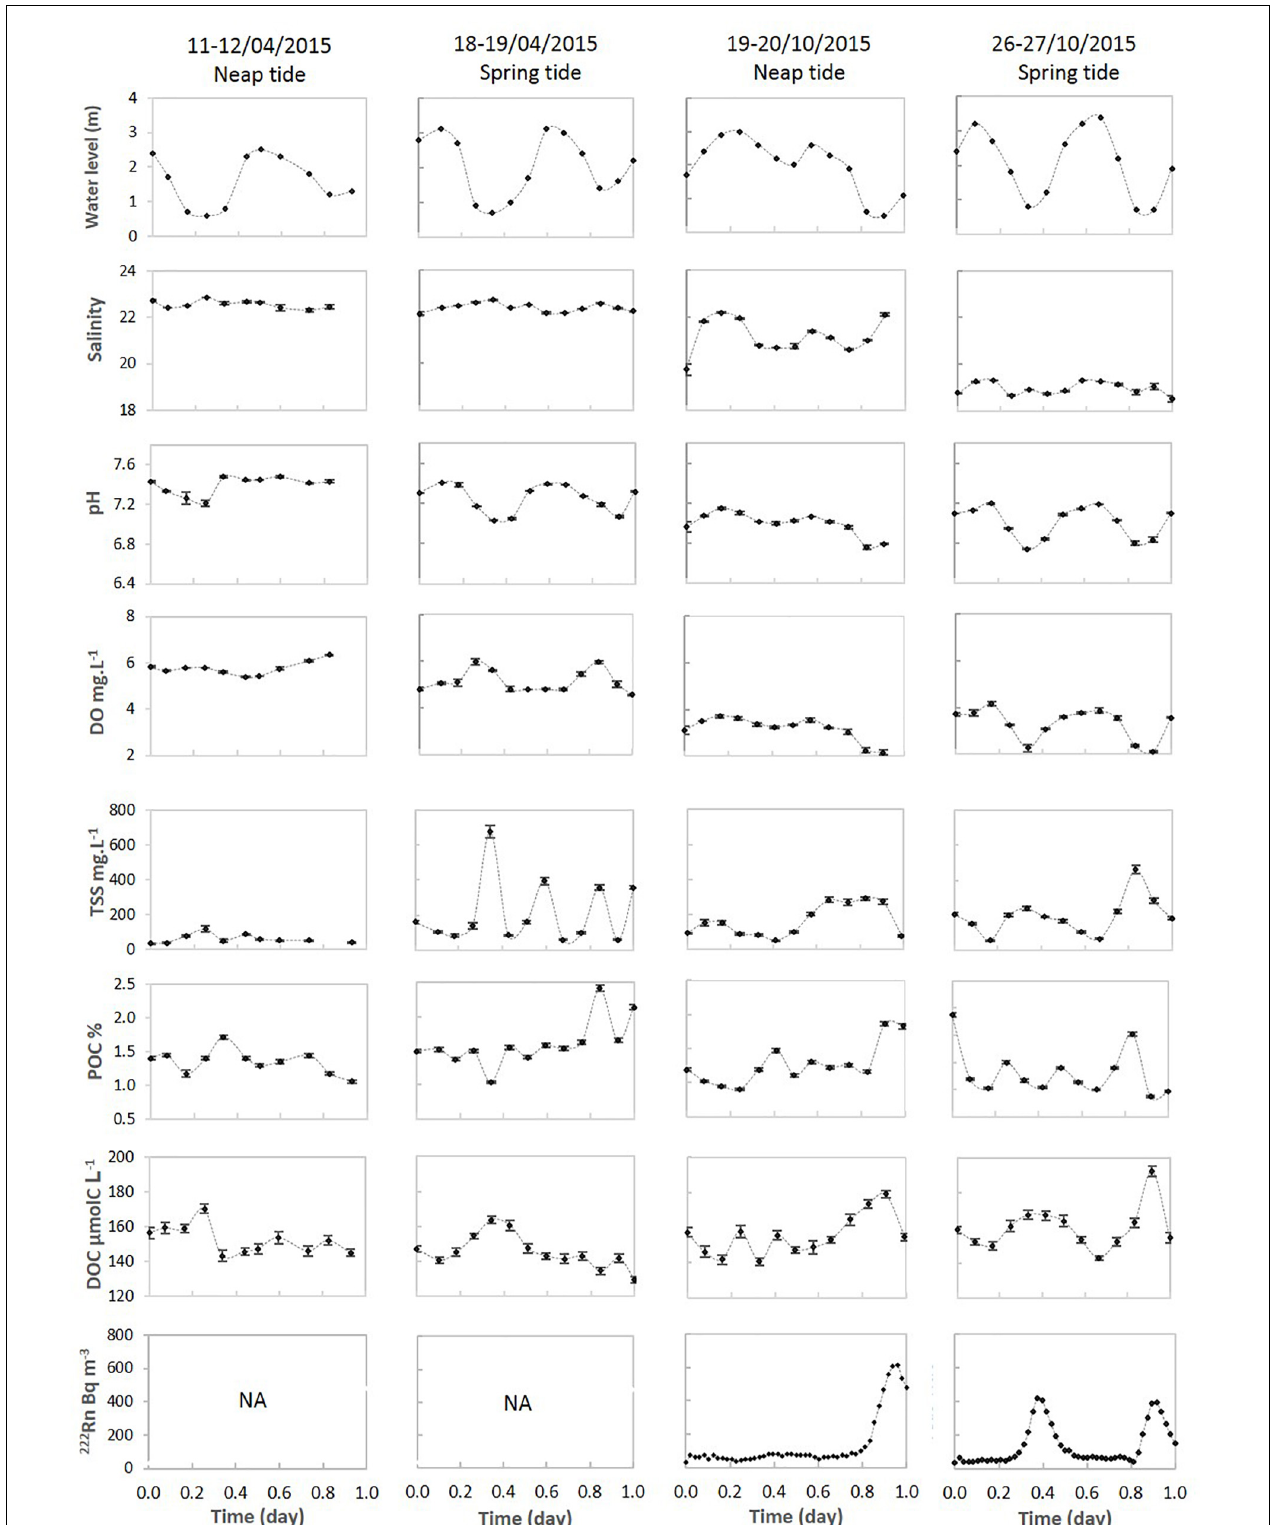
FIGURE 2 | Temporal variations of water level, salinity, pH, DO, TSS, POC, and DOC measured during neap and spring tidal cycles during the dry season (04/2015) and the wet season (10/2015). NA: not available.